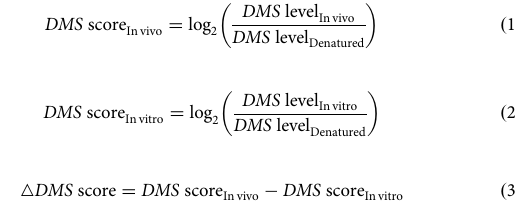
fraction) and RNA-RBP complexes (bound fraction) were resolved on 6% native-PAGE and analyzed by Typhoon FLA 7000 (GE healthcare). The assays were performed in triplicate and the average ratio between bound and total fractions was obtained by quantitating the band intensities using the Multi-gauge v3.0 program (Fig. 7c).